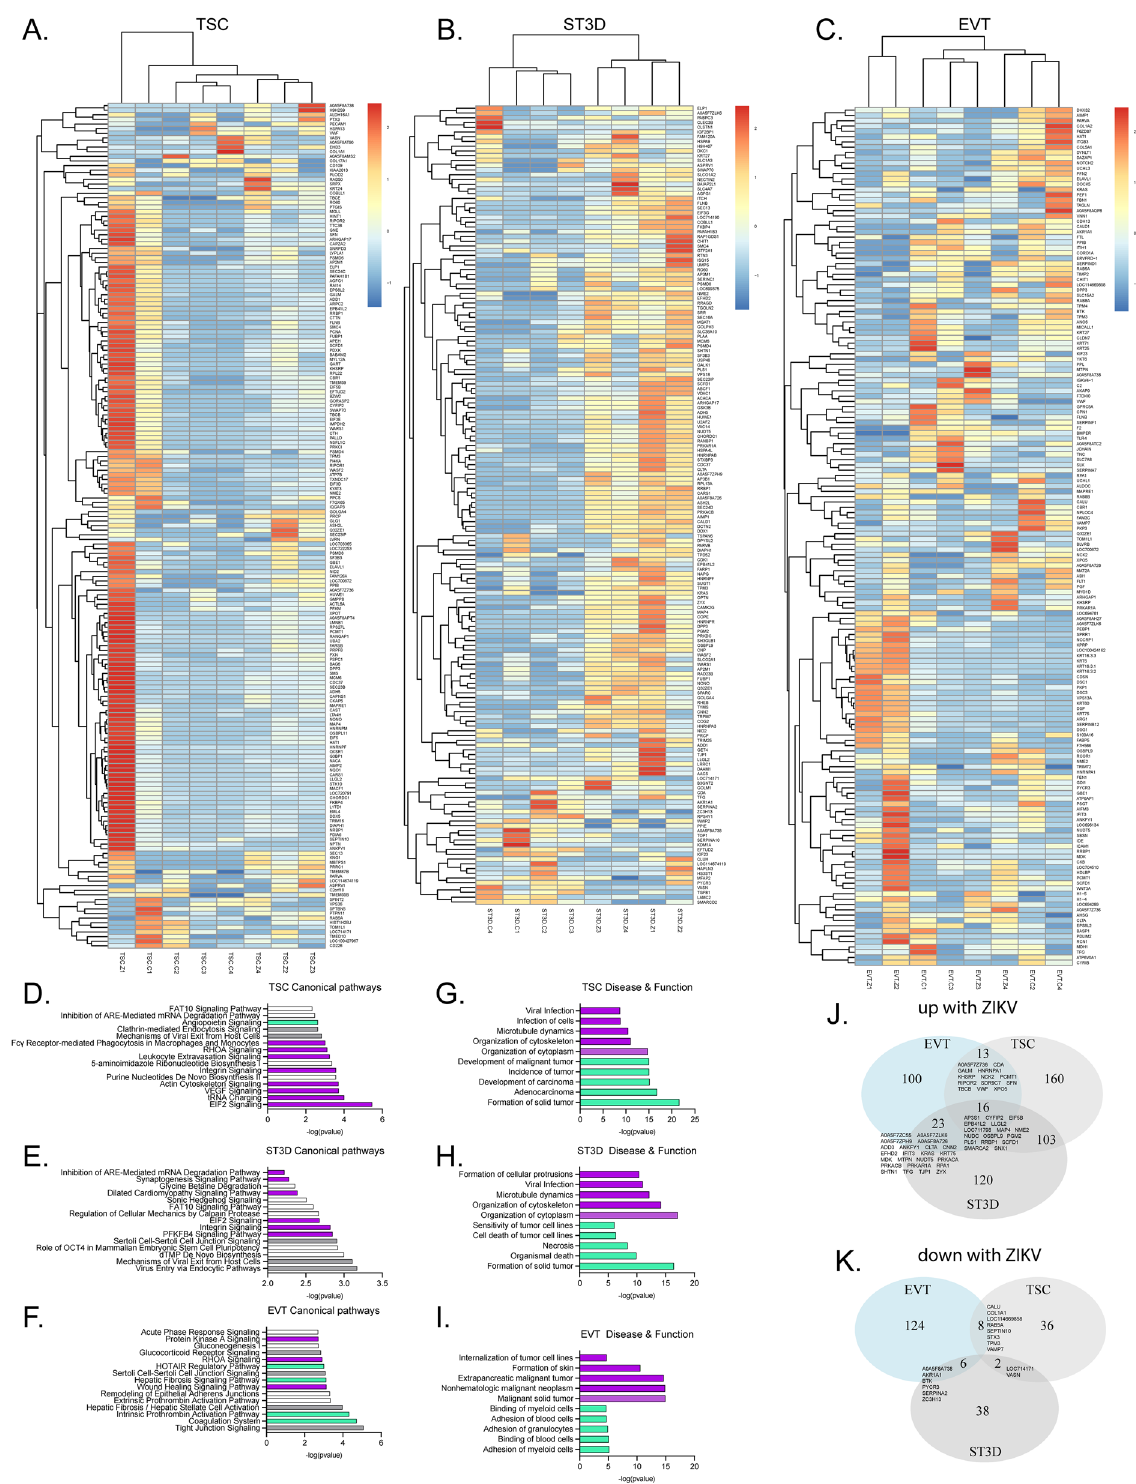
Figure 6. EV proteomics analysis. ( A – C ) Heatmaps of significantly differentially detected proteins present in at least half of TSC, ST3D, and EVT EV samples. ( D – F ) Top canonical pathways identified in the TSC, ST3D, and EVT EVs. Purple indicates a positive Z-score (activated); green indicates a negative Z-score (inhibited); white indicates 0 Z-score (no clear indication of whether the pathway is decreased or increased in ZIKV); and gray indicates unknown direction. ( G – I ) Top five predicted decrease (green) and top five predicted increase (purple) diseases and functions. ( J , K ) Venn diagrams of EV proteins increased or decreased with ZIKV